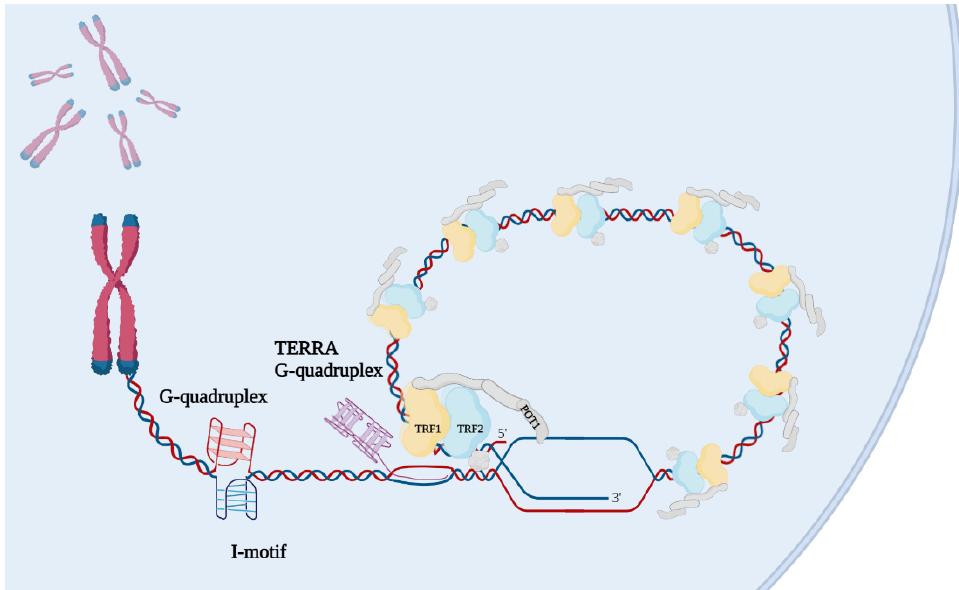
Figure 4. Recognized telomeric pharmacological targets. Besides telomerase and elongation